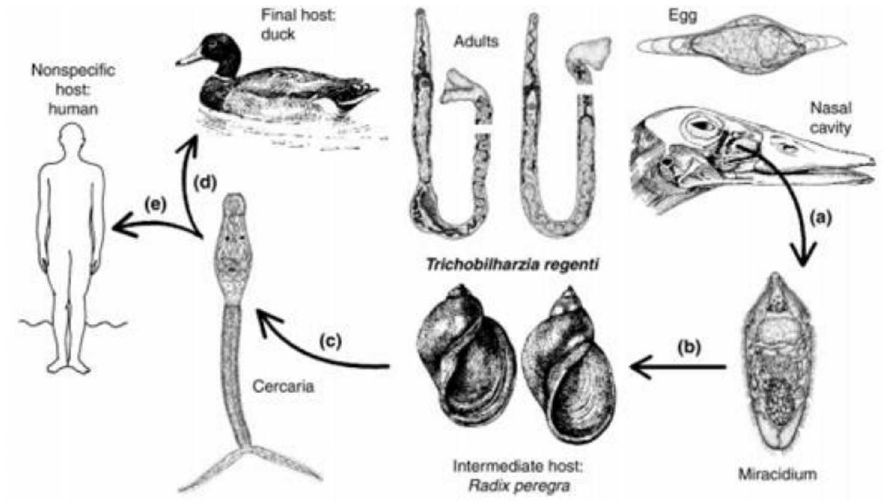
Figure 2. The life cycle of Trichobilharzia regenti : (a) mature worms lay the eggs in the nasal mucosa of ducks, then the eggs get to water and from these eggs miracidia hatch;(b)miracidia infect the intermediate hosts; (c) from these hosts cercariae are released; (d) they penetrate the skin of a specific host or (e) the skin of an incompetent mamma- lian host such as a human being (from